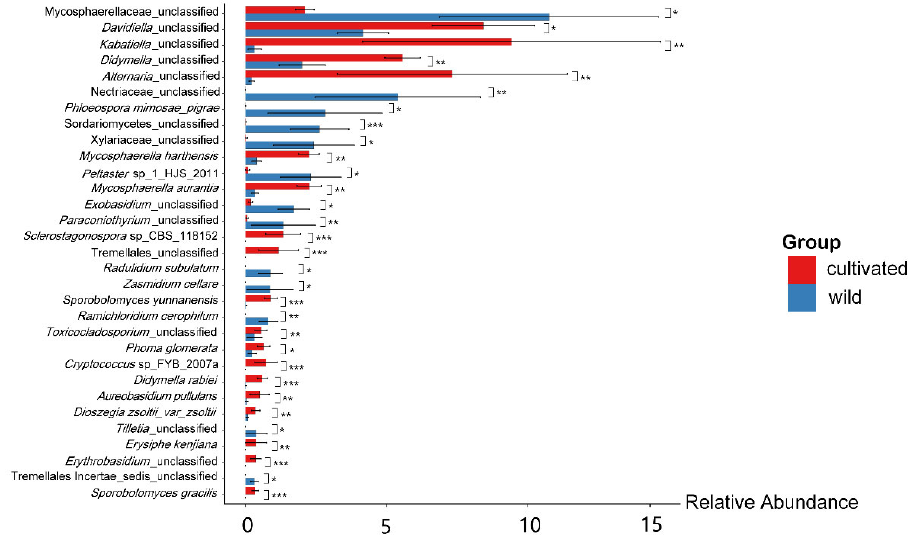
Figure 4. Barplot difference analysis of endophytic fungi at species level in wild L. delavayi and cultivated L. delavayi leaves. All species were analyzed for differences, and the species with p -value less than 0.05 (Wilcoxan test) were screened to draw a histogram (basically including all differential species). In the figure, * represents 0.01 < p < 0.05, ** represents 0.001 < p < 0.01, and *** represents p < 0.001. The ordinate in the figure represents the different species (arranged from left to right ac- cording to the abundance), and the abscissa is the relative abundance.